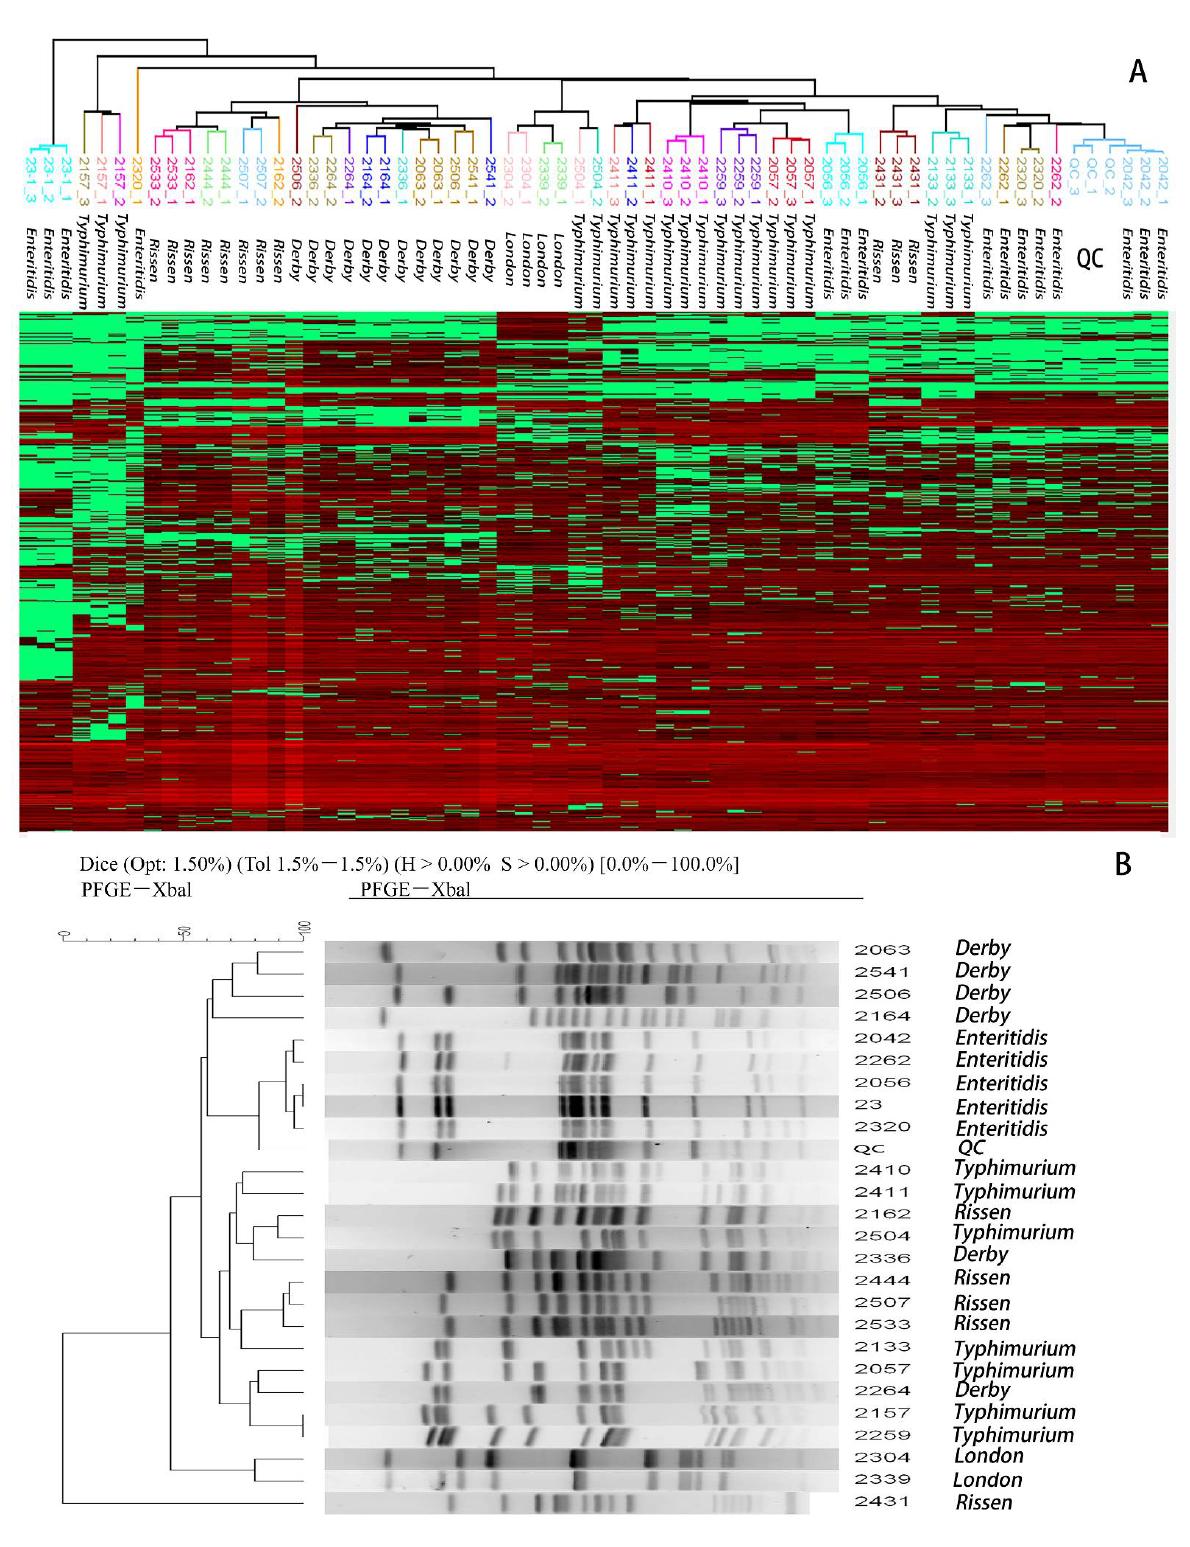
Figure 4. Hierarchical clustering to differentiate similarity among Salmonella enteric isolates. The cluster analysis by LC-MS/MS ( A ) and PFGE ( B ) in the training group. There was no evident similarity between Salmonella enteric